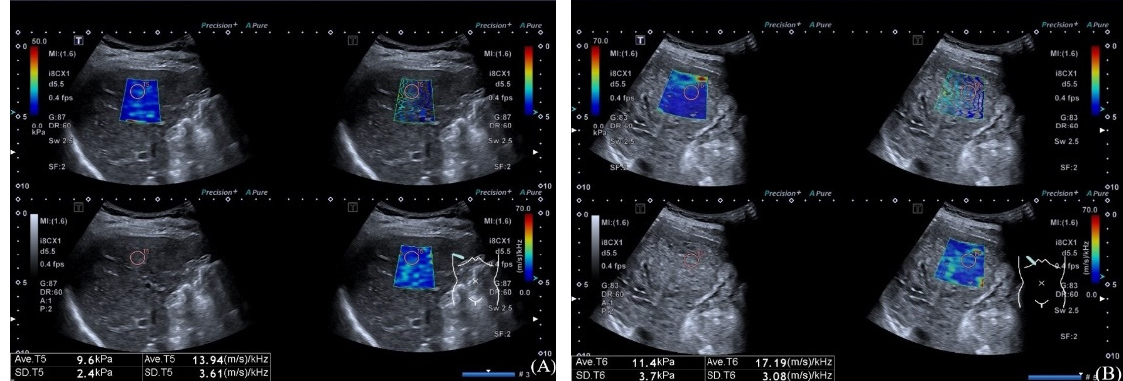
Figure 1. Four maps include an elasticity map (upper left), propagation map (upper right), B-mode map (lower left) and SWDS map (lower right): ( A ) images in a 50-year-old man who suffers hepatis B virus-related cirrhosis without variceal hemorrhage; and ( B ) images in a 52-year-old woman who suffers primary biliary cholangitis with variceal hemorrhage.